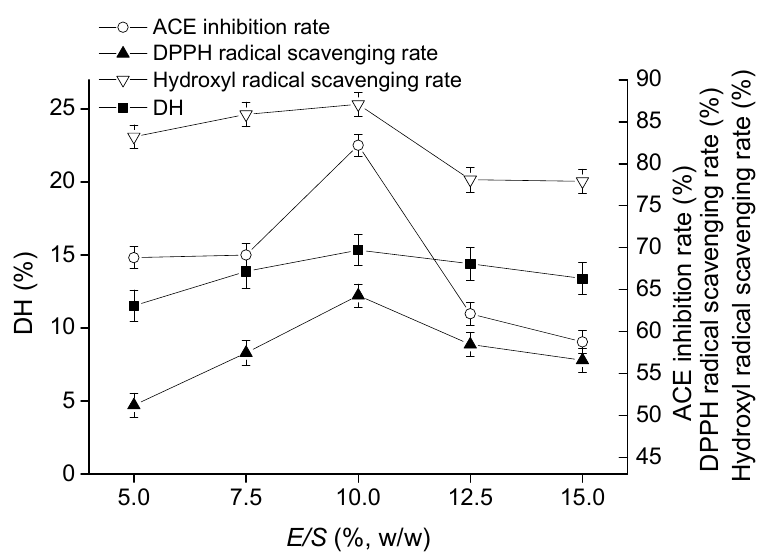
Figure 3. Effect of E / S on DH, ACE inhibitory activity, and antioxidant activity of hydrolysate at pH of 8, time of 4 h, and temperature of 41 °C. The error bars represent standard deviation of means ( n = 3).